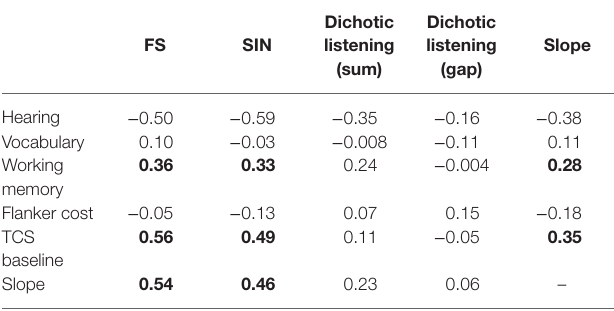
TABLE 2 | Cognition and speech perception. OHI OHI-HA Cognition